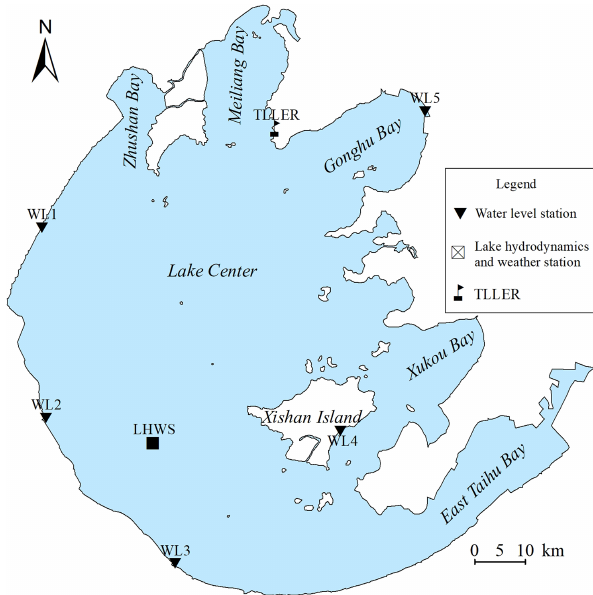
Figure 1. Location of the Taihu Laboratory for Lake Ecosystem Research (TLLER), the five water level stations (WL1–WL5), and the lake hydrodynamics and weather station (LHWS) for recording the lake currents and meteorological